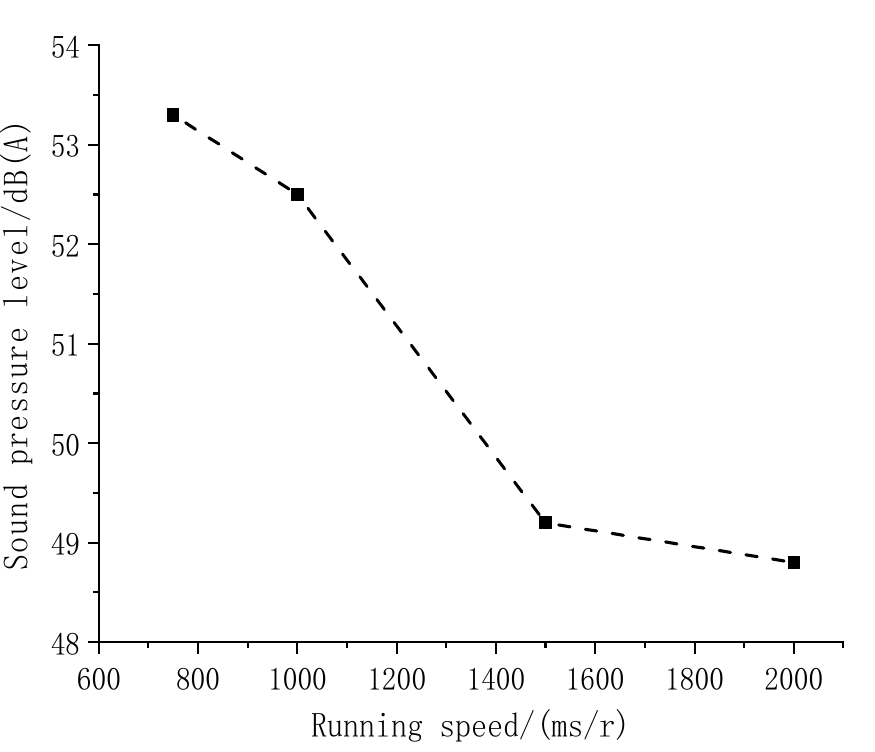
Figure 6. The pavement noise sound pressure level at different driving speeds.